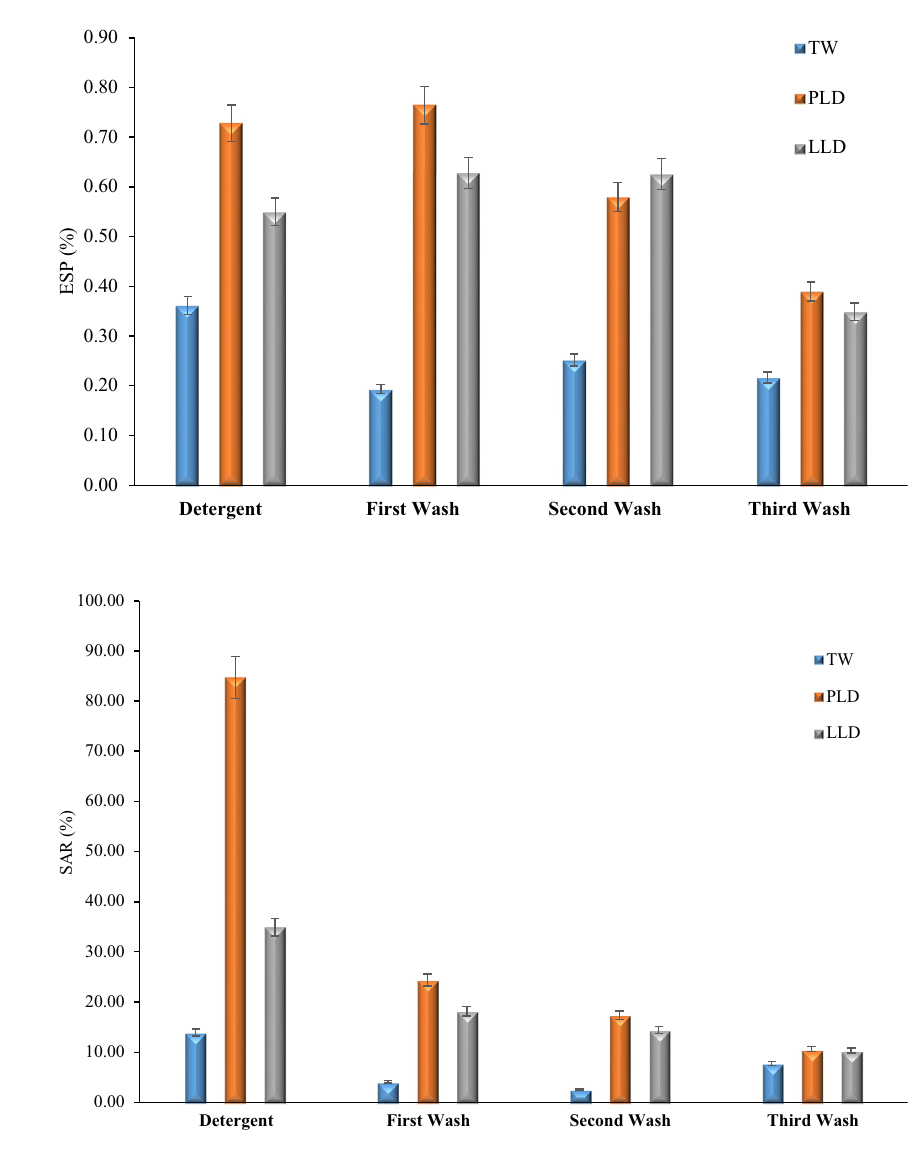
Fig. 4 Exchangeable sodium (ESP) percentage of soil leachate after irrigated with tap water (TW), powder laundry detergent (PLD) and liquid laundry detergent (LLD) grey- water